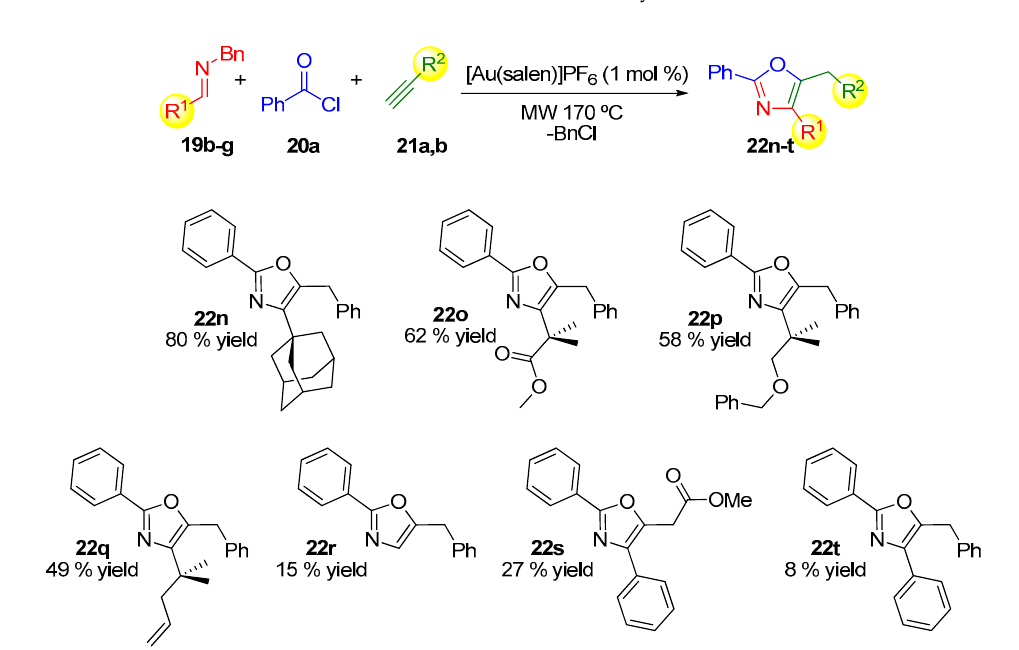
Scheme 8. Structural variations in the imines 19 .